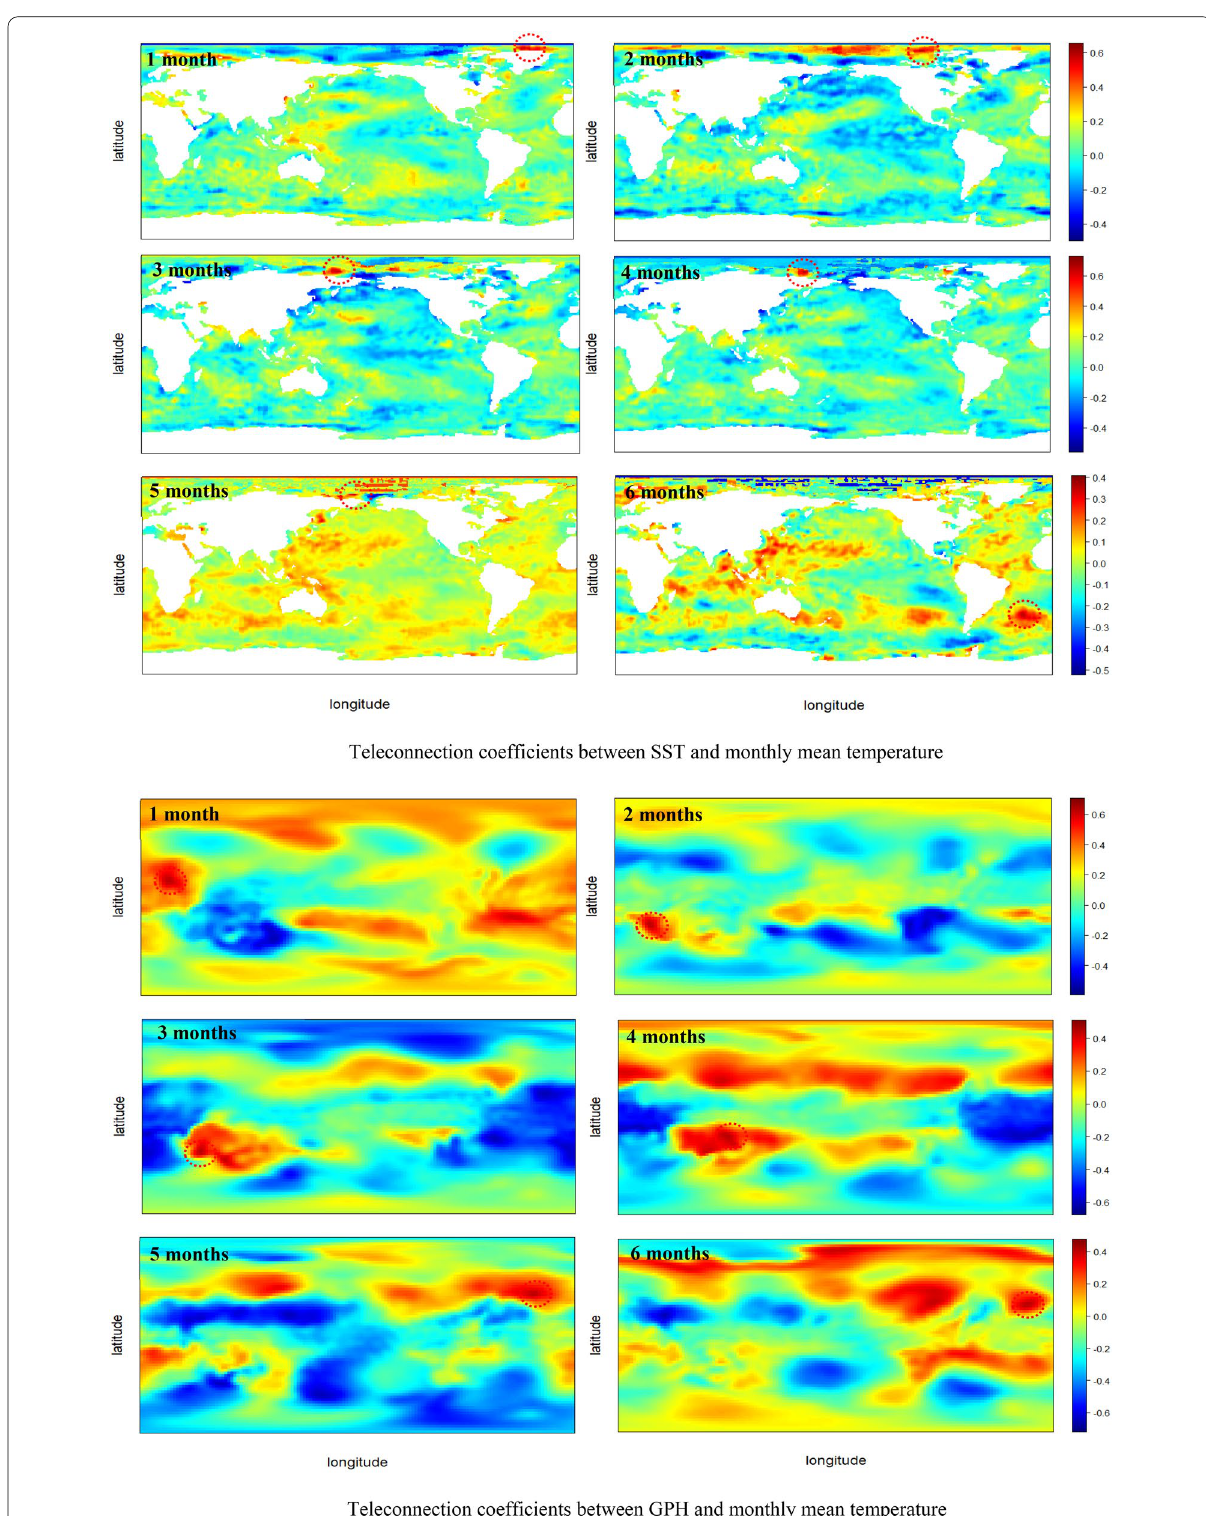
Fig. 25 Teleconnection coefficients between the global-scale climate indices and monthly mean